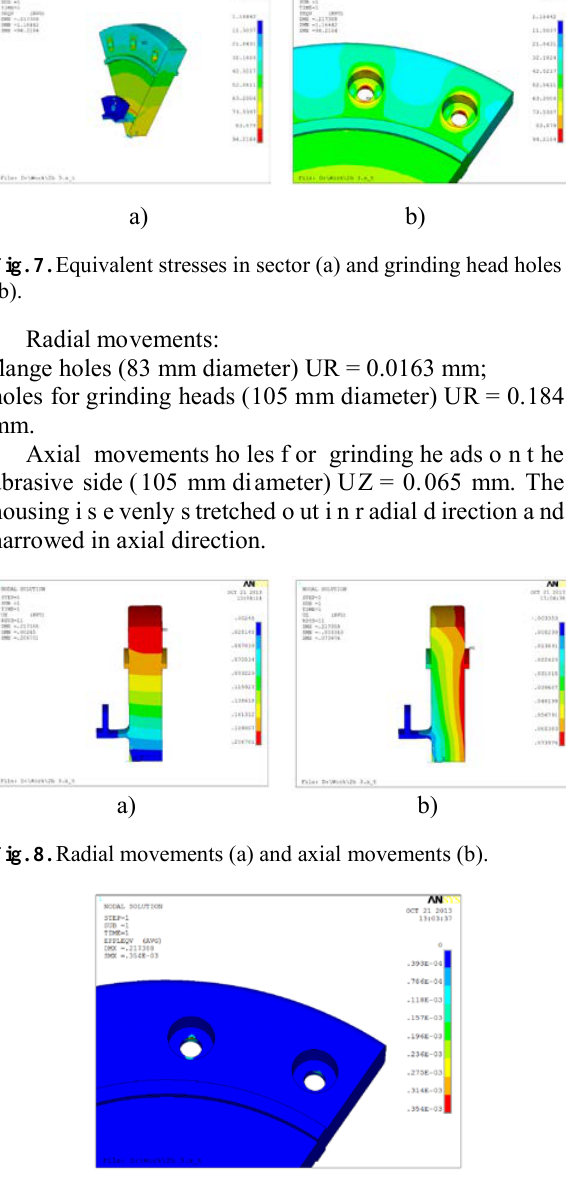
Table 3. Grinding head weight calculation.